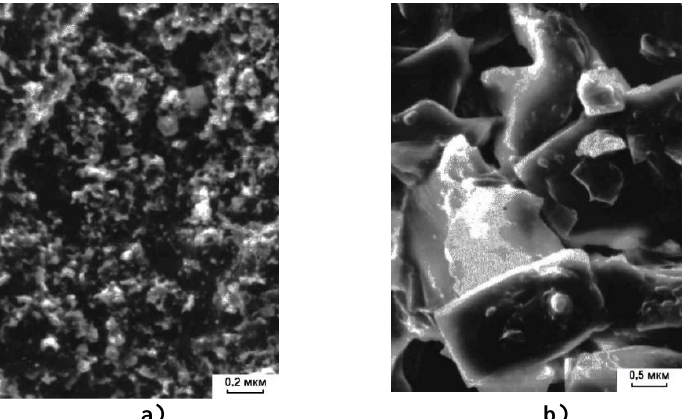
Fig.3. Changes in the structure of the nanoglass-composite coating with increasing distance from the friction surface in a layer ~6 µm thick: a) near-surface zone; b) undeformed